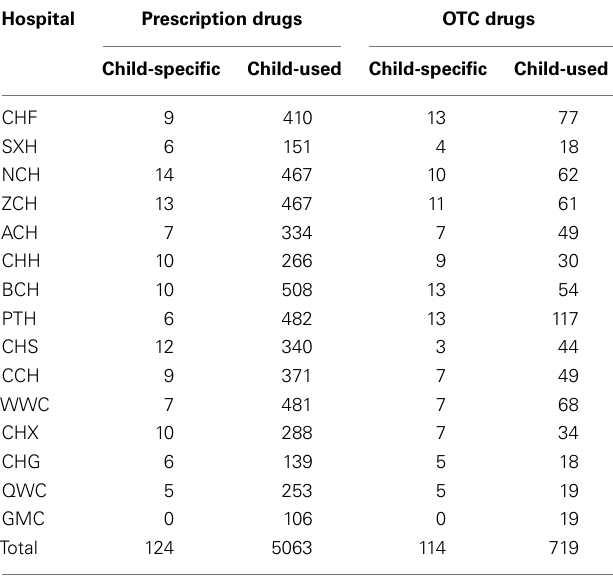
Table 1 | Pediatric medication usage in selected hospitals